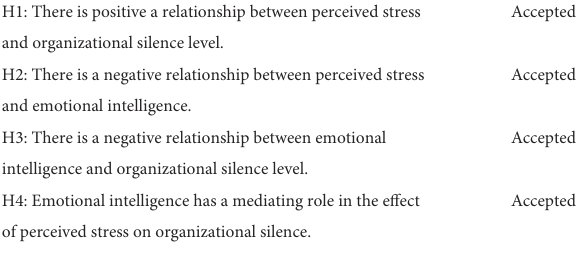
TABLE 4 Hypothesis test